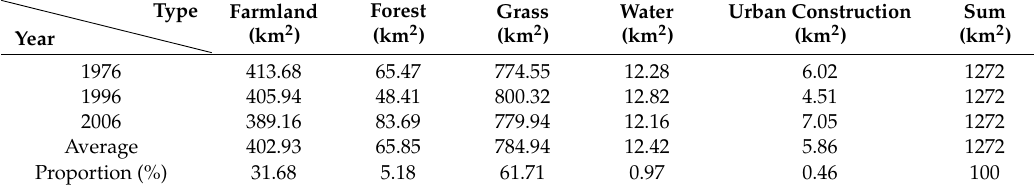
Figure 4. Land use changes of Gushanchuan basin. Table 6. Land use classification statistics of Gushanchuan basin.